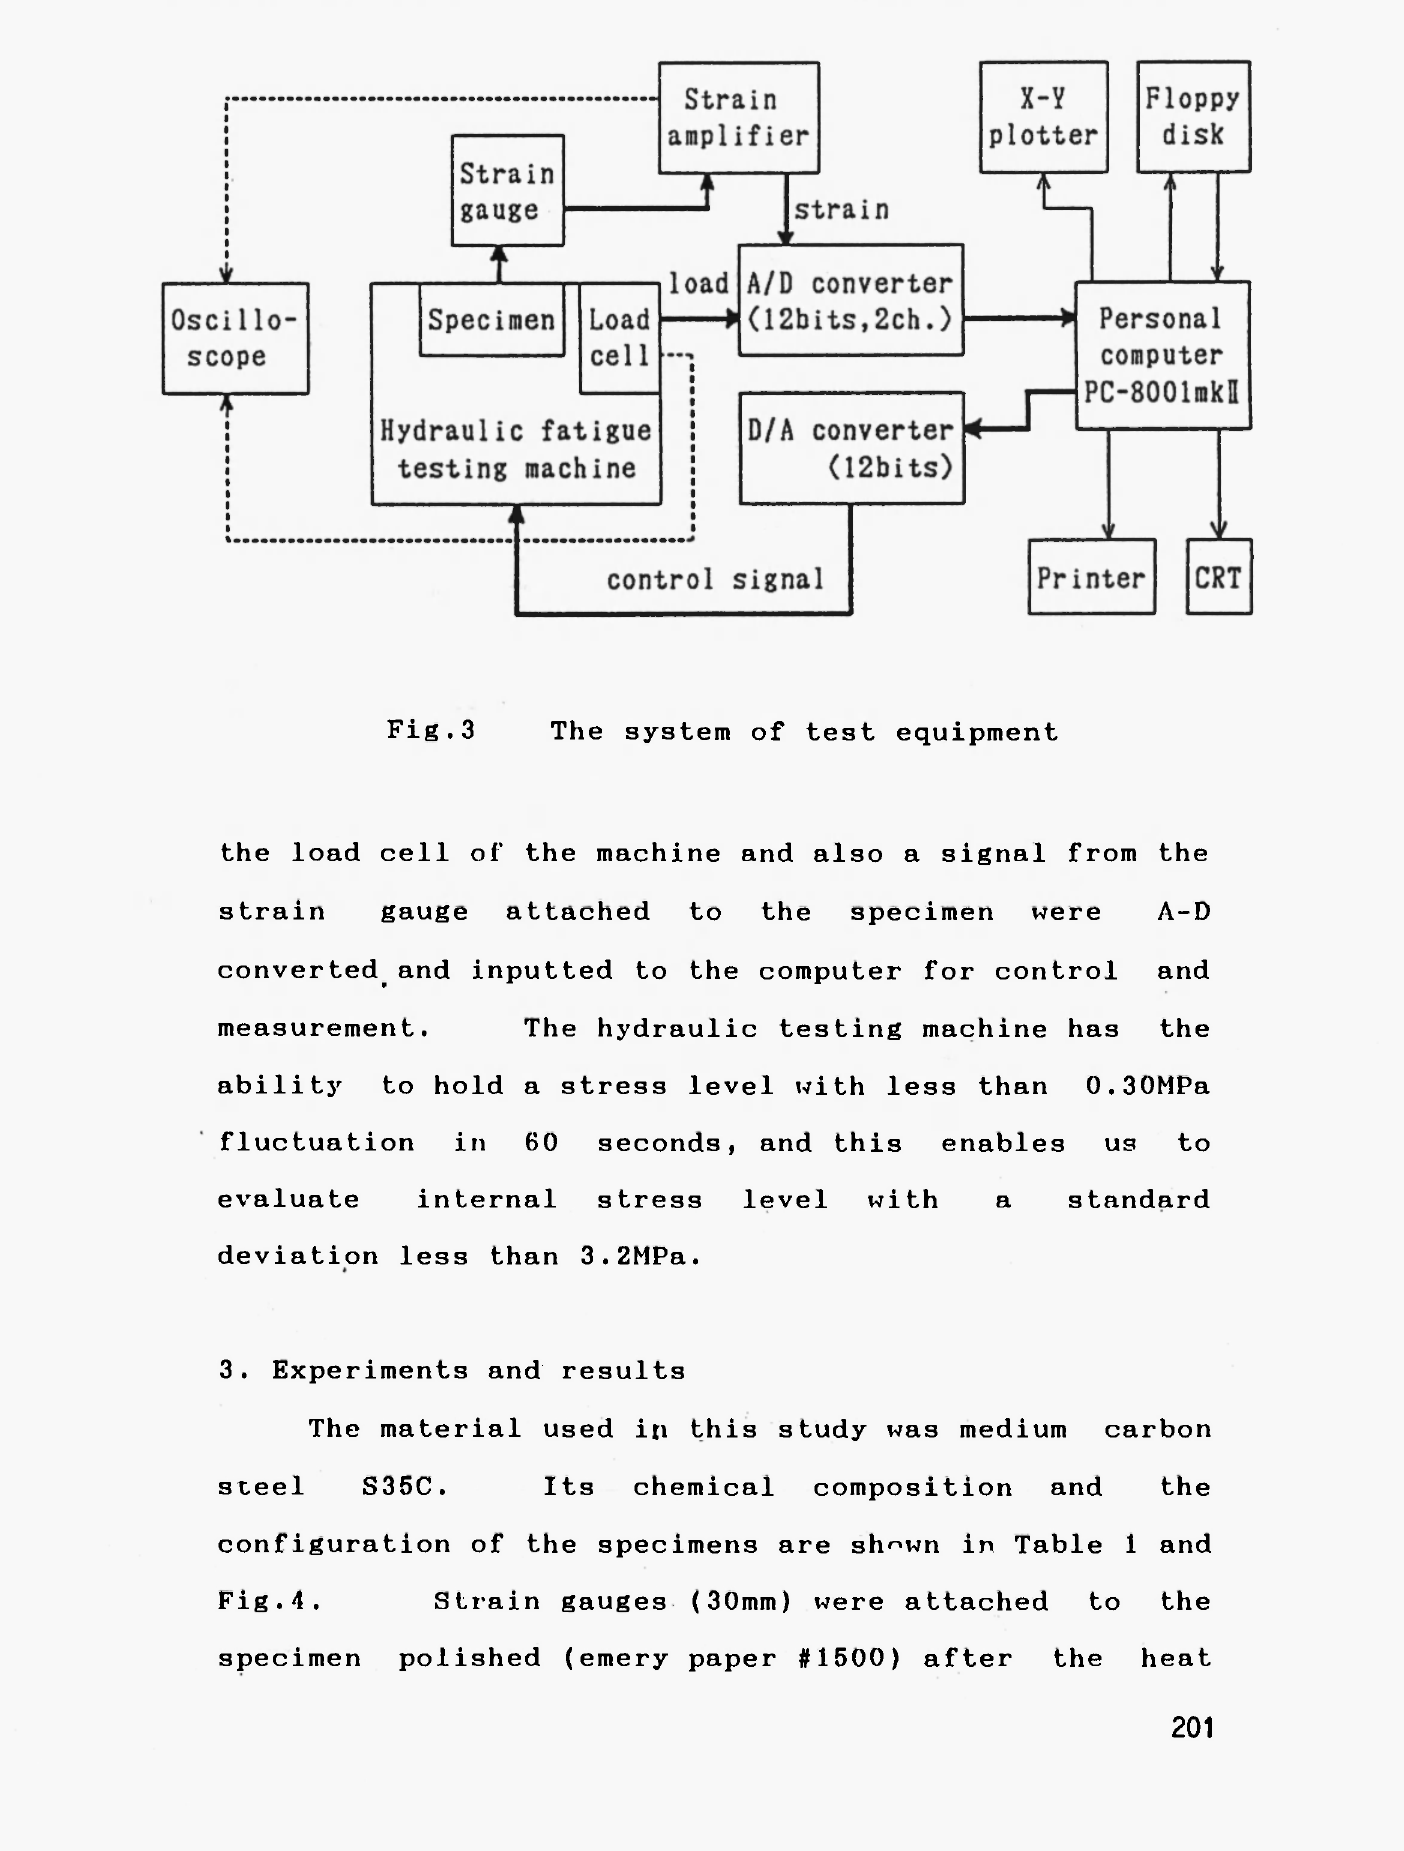
Fig.4. Strain gauges (30mm) were attached to the specimen polished (emery paper #1500) after the